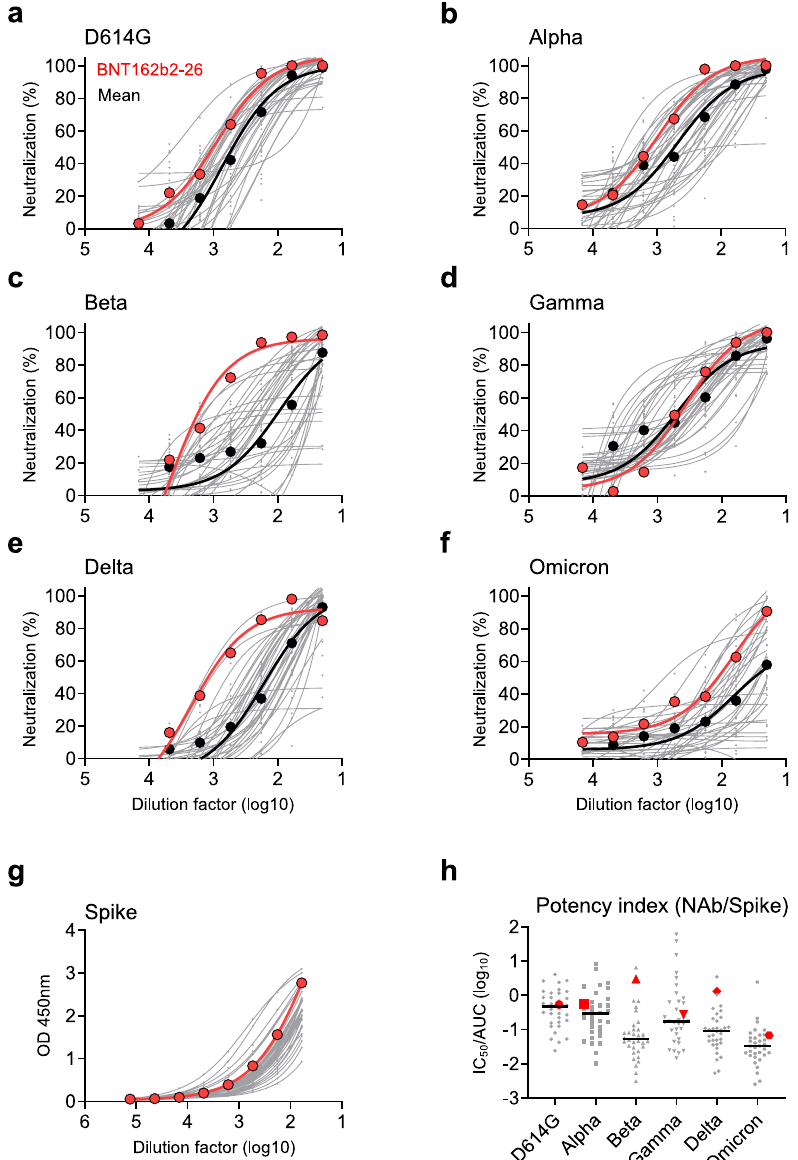
Fig. 1 Identi fi cation of a vaccinee who developed bNAbs. Plasma samples derived from 34 BNT162b2-vaccinees were tested at average 30.7 days (range 7-47 days) after second vaccination. a – f Serially diluted plasma samples were subjected to neutralization assay against the pseudotyped SARS-CoV-2 WT ( a ) and fi ve VOCs ( b – f ), respectively. The neutralizing curve of the BNT162b2-26 vaccinee (red) was compared with the mean curve of all vaccinees tested (dark black). g Binding activity of spike-speci fi c plasma IgG was determined by ELISA at serial dilutions. The binding curve of the BNT162b2-26 vaccinee was presented in red. h The neutralization antibody potency index was de fi ned by the ratio of IC 50 /AUC of anti-spike IgG in BNT162b2-vaccinees. Neutralizing IC 50 values represented plasma dilution required to achieve 50% virus neutralization. The area under curve (AUC) represented the total peak area was calculated from ELISA OD values. Each symbol represented an individual vaccinee with a line indicating the median of each group. The BNT162b2- 26 vaccinee who developed bNAbs was presented as red symbols. The experiments were performed in parallel. Source data are provided as a Source Data fi le. bNAbs broadly neutralizing antibodies, WT wildtype, VOC variant of concern, ELISA enzyme-linked immunosorbent assay, IC 50 half inhibitory concentration, AUC area under curve, OD optical NAbs were all considered as public antibodies characterized by a Fig. 2h and Supplementary Table 5). In subsequent quantitative neutralization analysis against WT, we found that two of these four NAbs, ZCB3 and ZCB11, showed high neutralization potency with IC 50 values below 100 ng/mL (Fig. 2c, Supplemen- tary Table 6). Sequence analysis revealed that ZCB3, ZCC10, and ZCD3 utilized IGHV3-53/3-66 heavy chain, whereas their paired light chains had distinct IGKV1-9, IGKV3-20, and IGKV1-27, respectively (Supplementary Table 7). In contrast, ZCB11 utilized Antibody neutralization of SARS-CoV-2 VOCs . To understand IGHV1-58 heavy chain and IGKV3-20 light chain. Our four new the breadth of these four newly cloned public RBD-speci fi c NAbs,